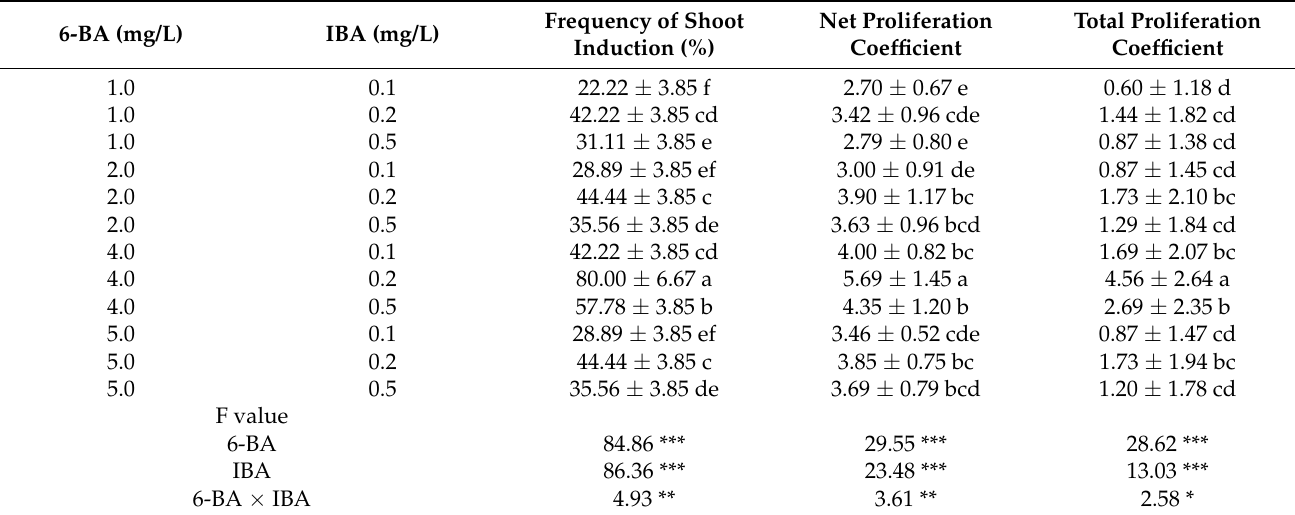
Table 7. Effects of 6-BA and IBA on adventitious shoot induction and proliferation.